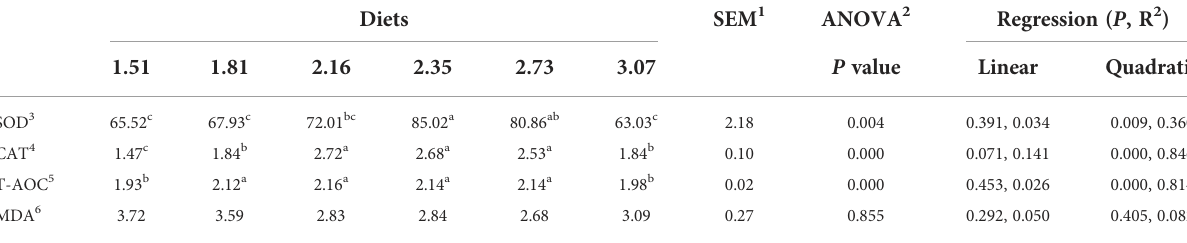
TABLE 7 Antioxidant parameters in the whole-body of postlarval S. paramamosain fed the experiment diets for 8 weeks.